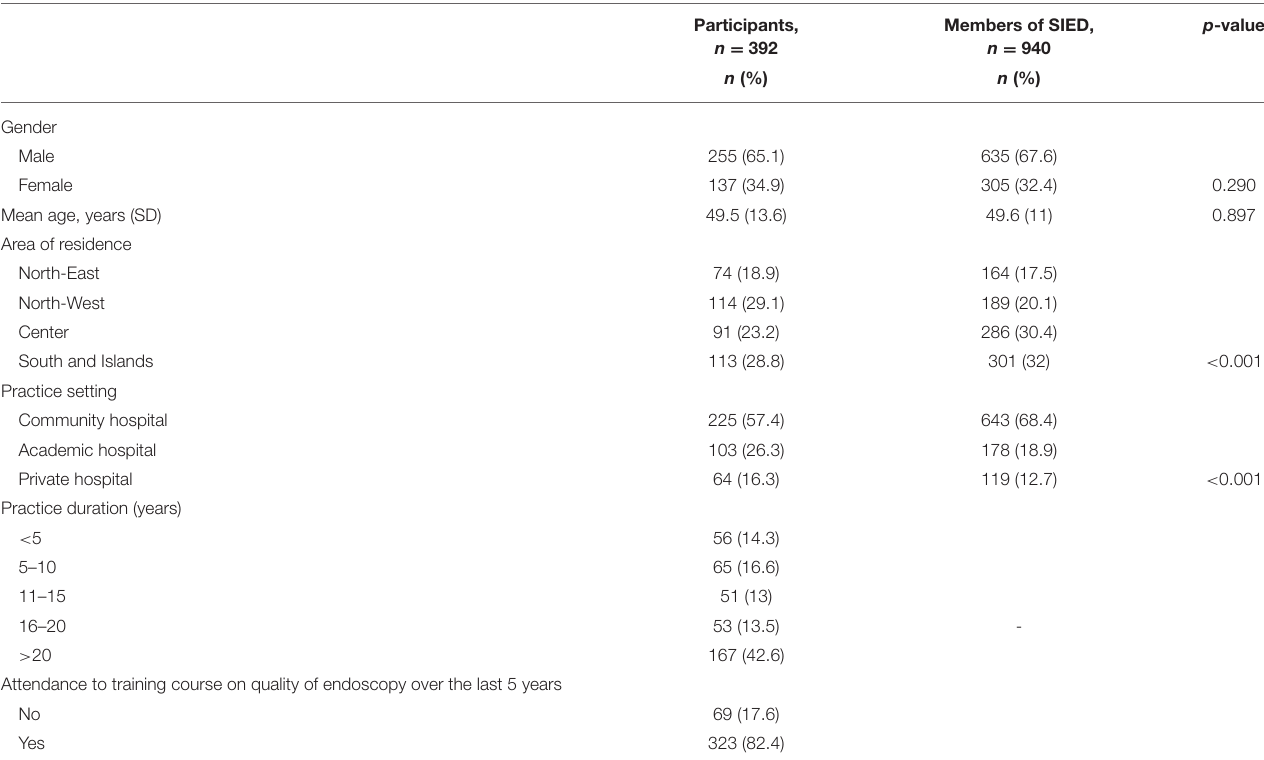
TABLE 1 | Demographic and professional characteristics of